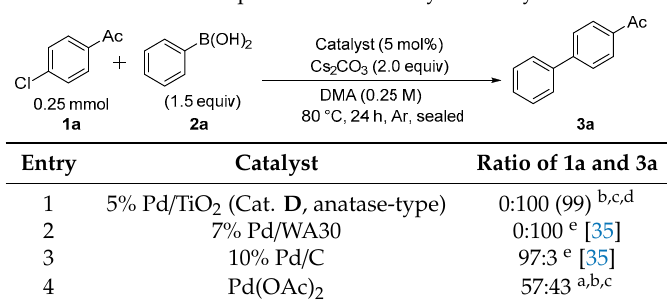
Table 3. Comparison of the catalyst activity. a